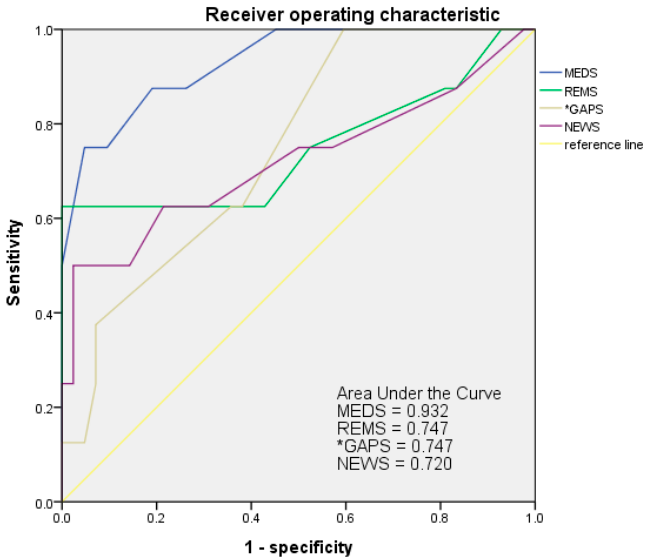
Figure 1. ROC of MEDS, REM, GAPS, and NEWS was analyzed to show the accuracy in predicting the mortality risks of patients with EPN. The AUC of ROC for MEDS, REMS, GAPS, and NEWS indicated 0.932, 0.747, 0.747, and 0.720, respectively. AUC = Area under the curve; ROC = Receiver operating characteristic curve.